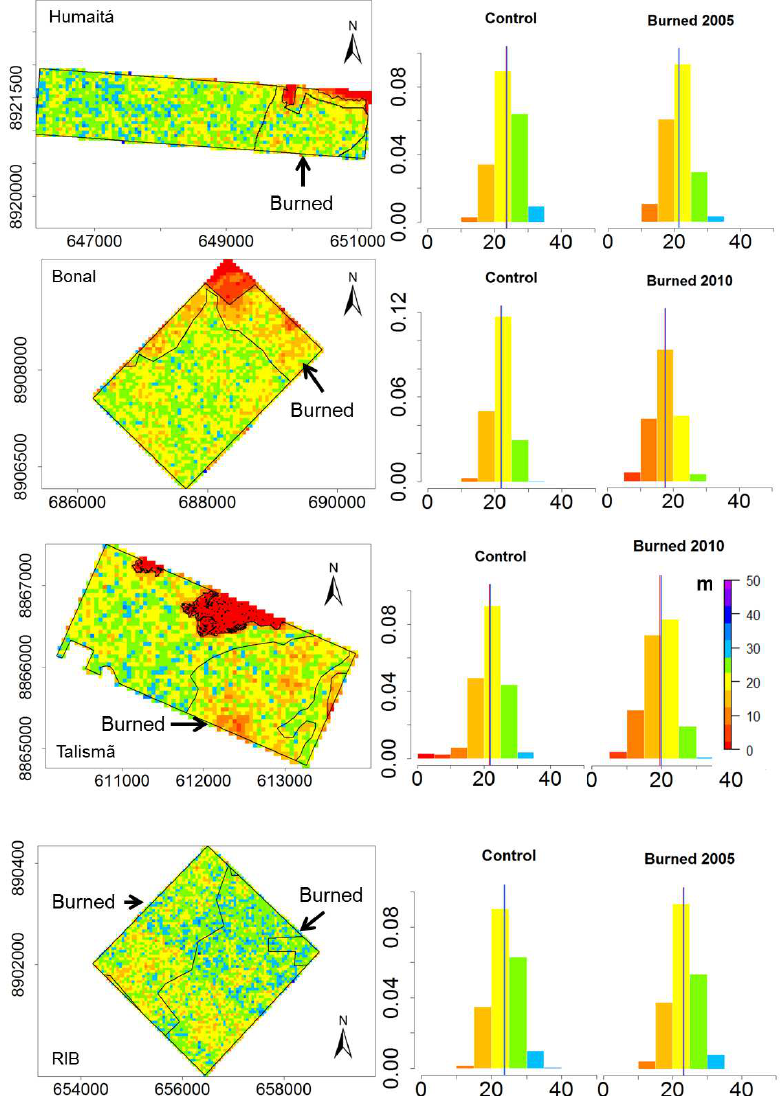
Figure 4. Map of Height (on the left) and a histogram of the heights distribution of the control and burned areas (on the right) for Humaitá, Bonal, Talismã and Rio Branco. On the histogram, the red lines are the average heights and the blue lines are the median